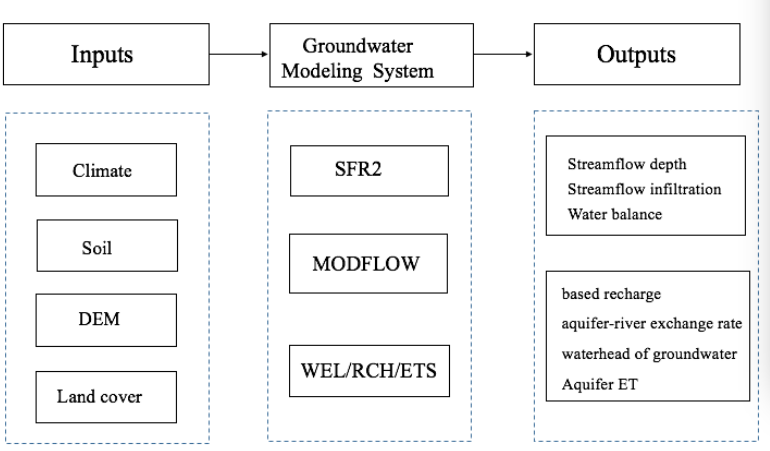
Figure 5. The structure of the GMS for the lower reach.